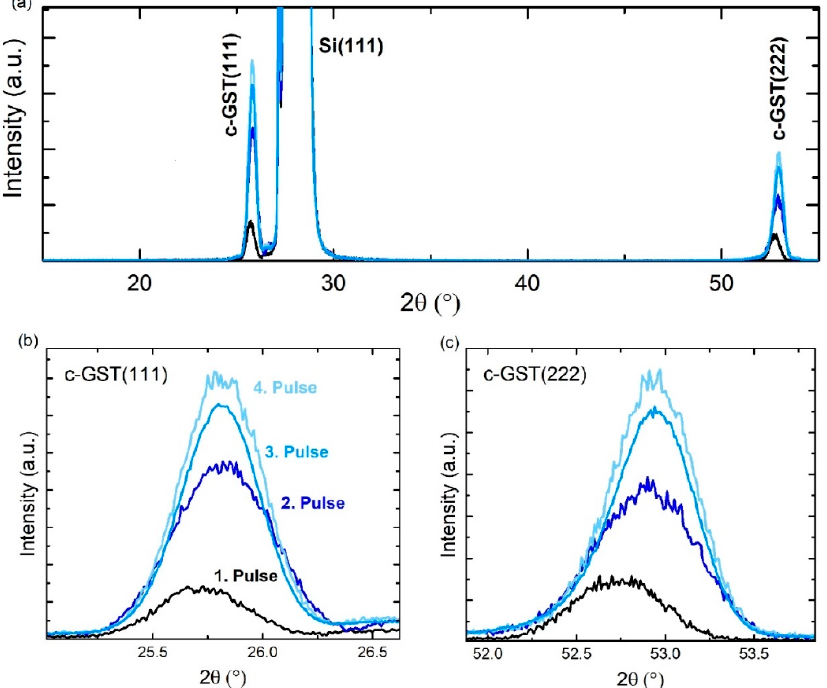
Figure 5. ( a ) XRD ω − 2 θ patterns of a GST thin film after application of successive single ns-laser pulses at 21 mJ / cm 2 fluence. XRD patterns in the vicinity of the ( b ) c-GST (111) and ( c ) c-GST (222) reflections. The thickness of the GST thin film was approximately 20 nm.